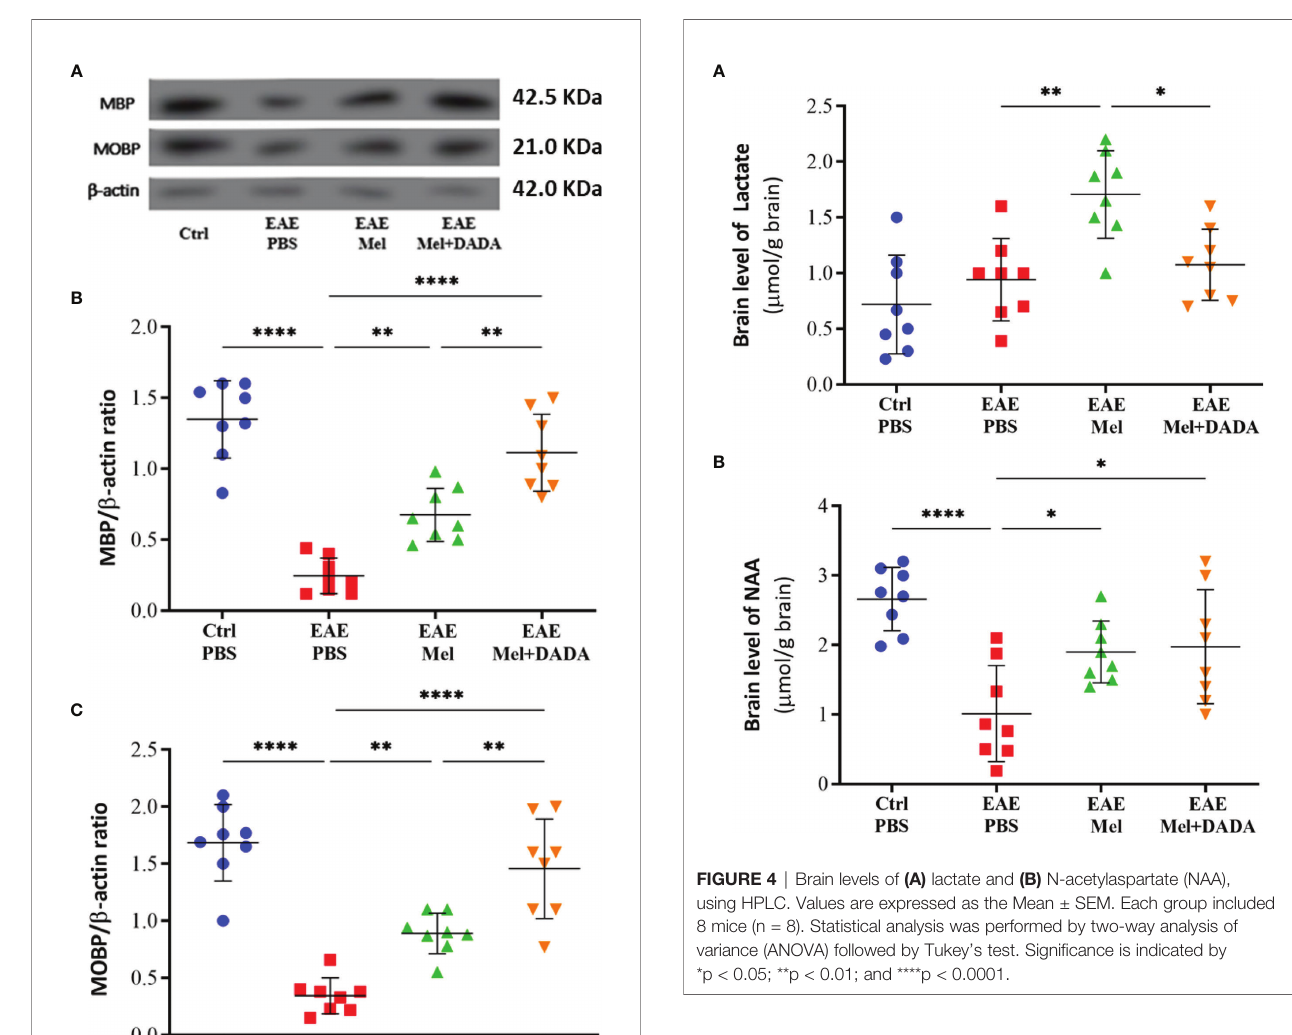
EAE mice (**p=0.0019 and ****p<0.0001, respectively)